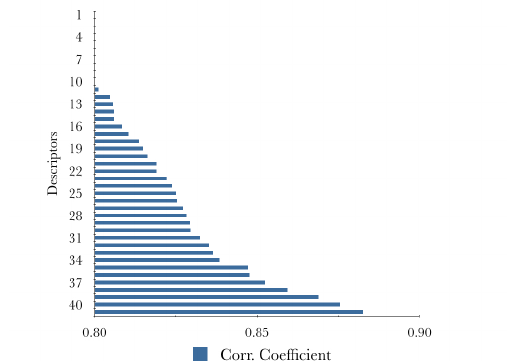
Fig. 3: Bar chart representations of Descriptor- experimental pIC 50 correlation coefficient. Only 31 out of 41 descriptors lie above 0.8 coefficient cutoff.